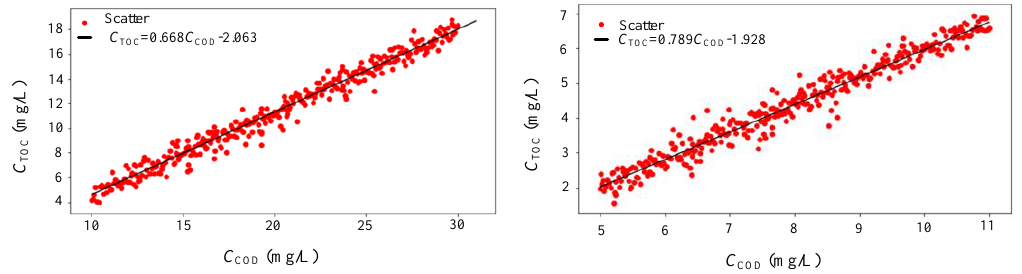
Figure 2. Chemical oxygen demand/total organic carbon (COD/TOC) relationship line of ground water 1 and ground water 2.